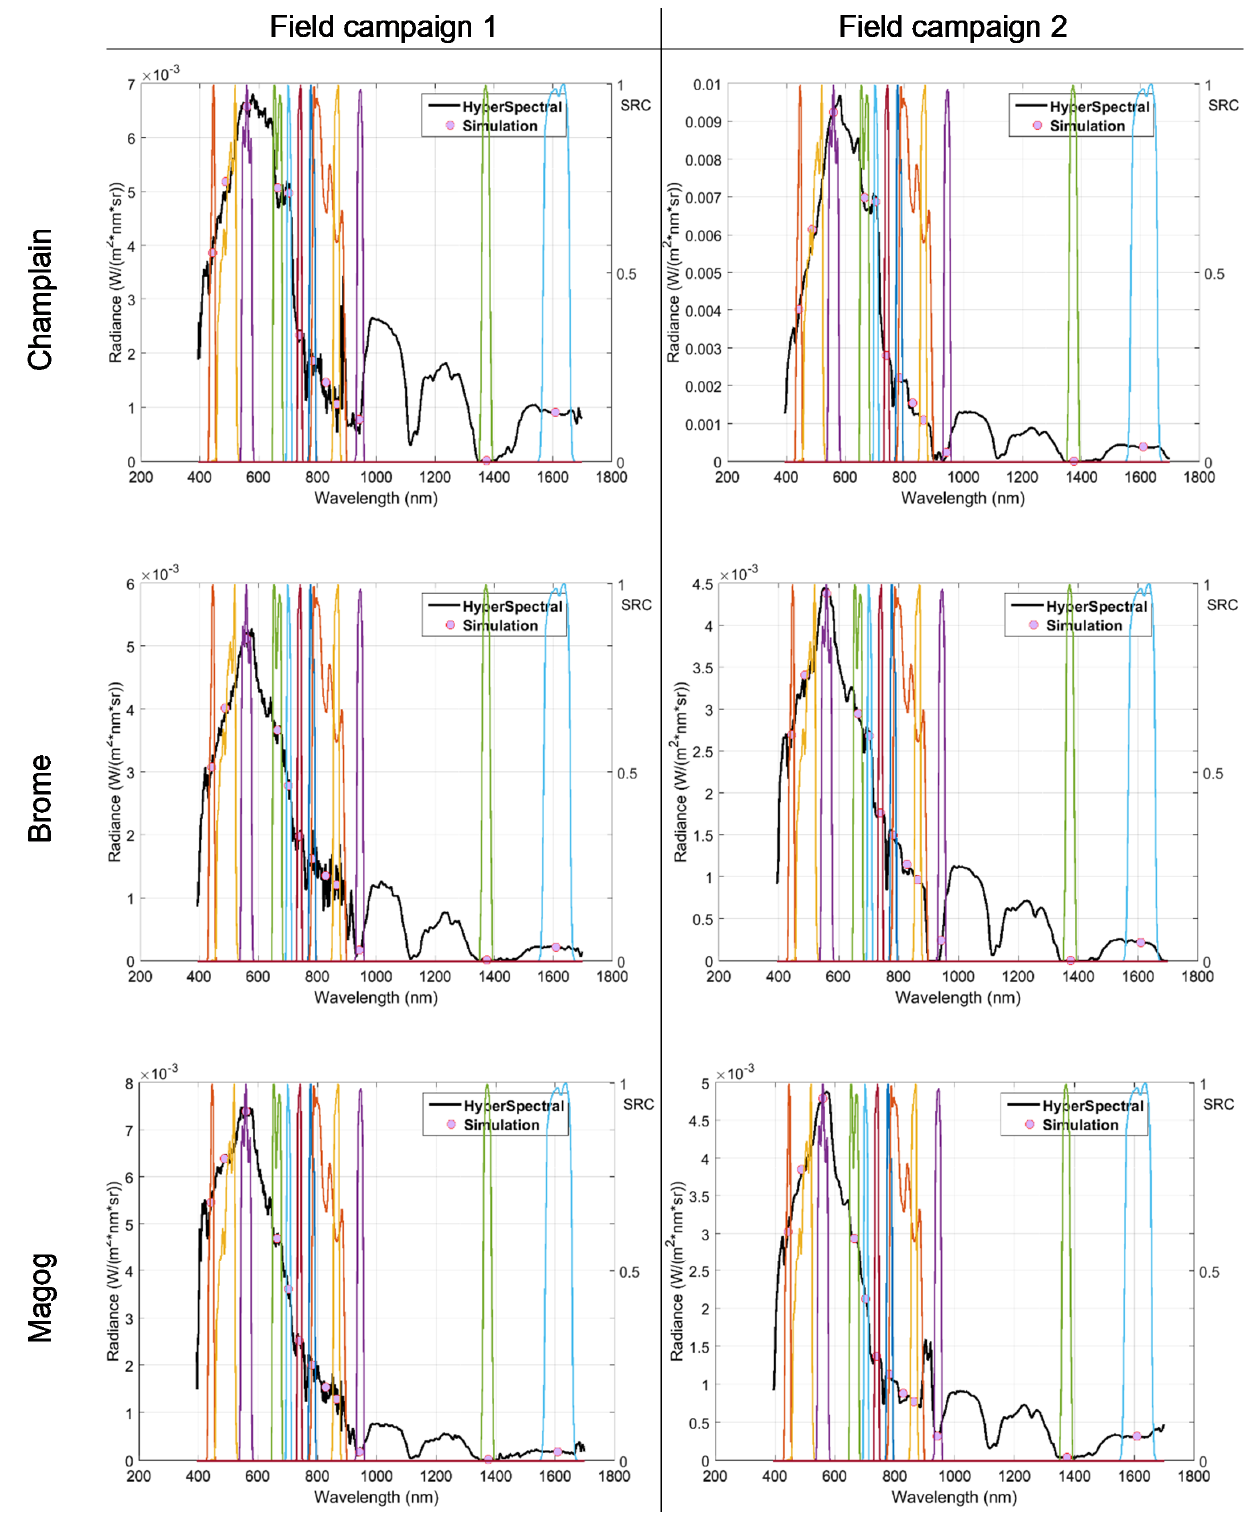
Figure 6. Averages of the hyperspectral radiance (black lines) and the multispectral radiance simulated (red dots) for the 13 Sentinel-2 bands in the function of their Spectral response curves (SRC).